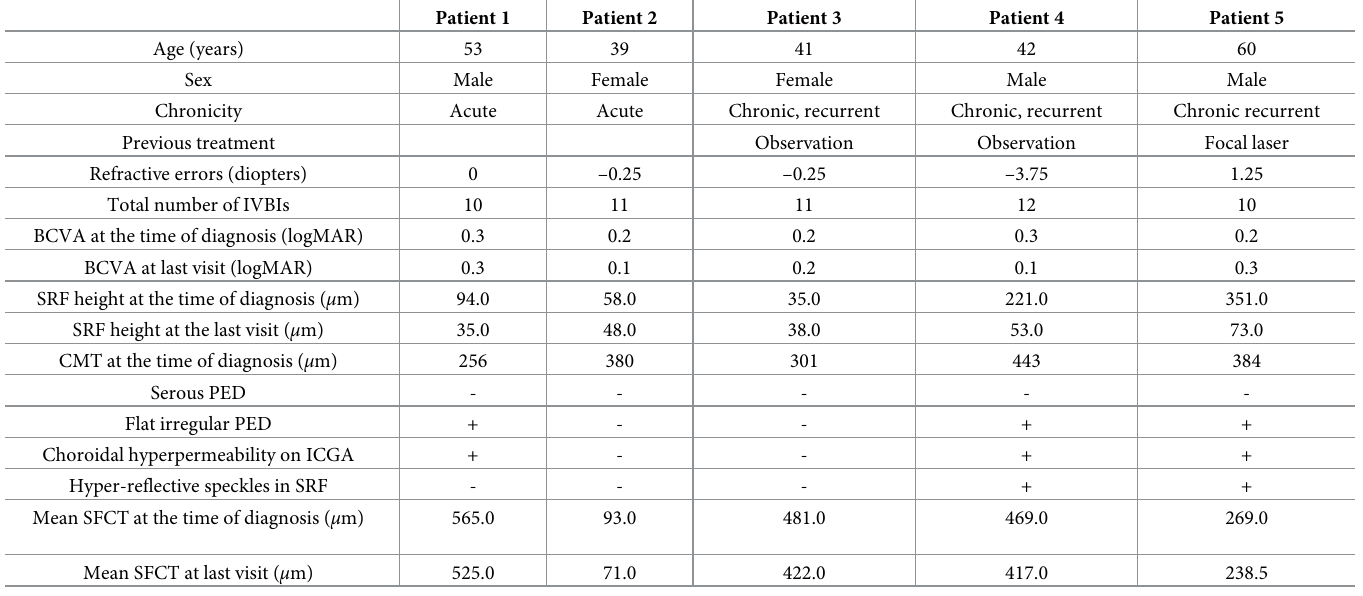
Table 1. Characteristics of the five patients who did not have at least one complete resolution of central serous chorioretinopathy after the intravitreal bevacizumab